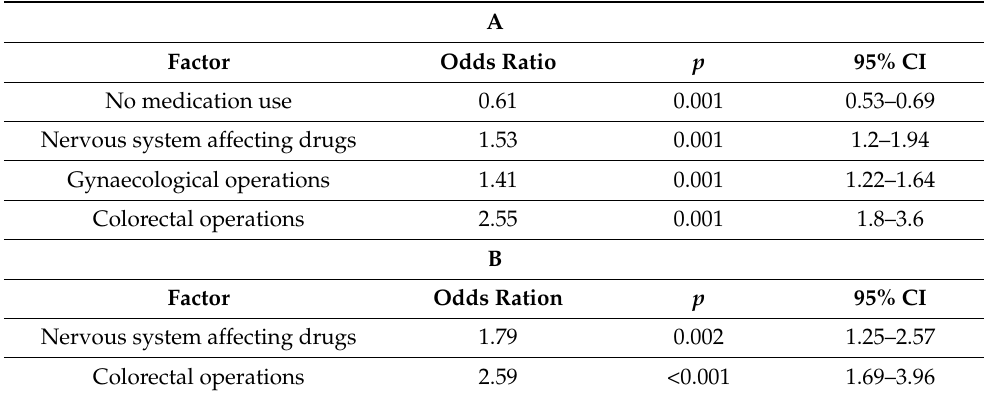
Table 5. Multivariate analysis of risk factors for major low anterior resection syndrome (LARS) score of whole population ( A ) and in 50 to 75 years old patients’ group ( B